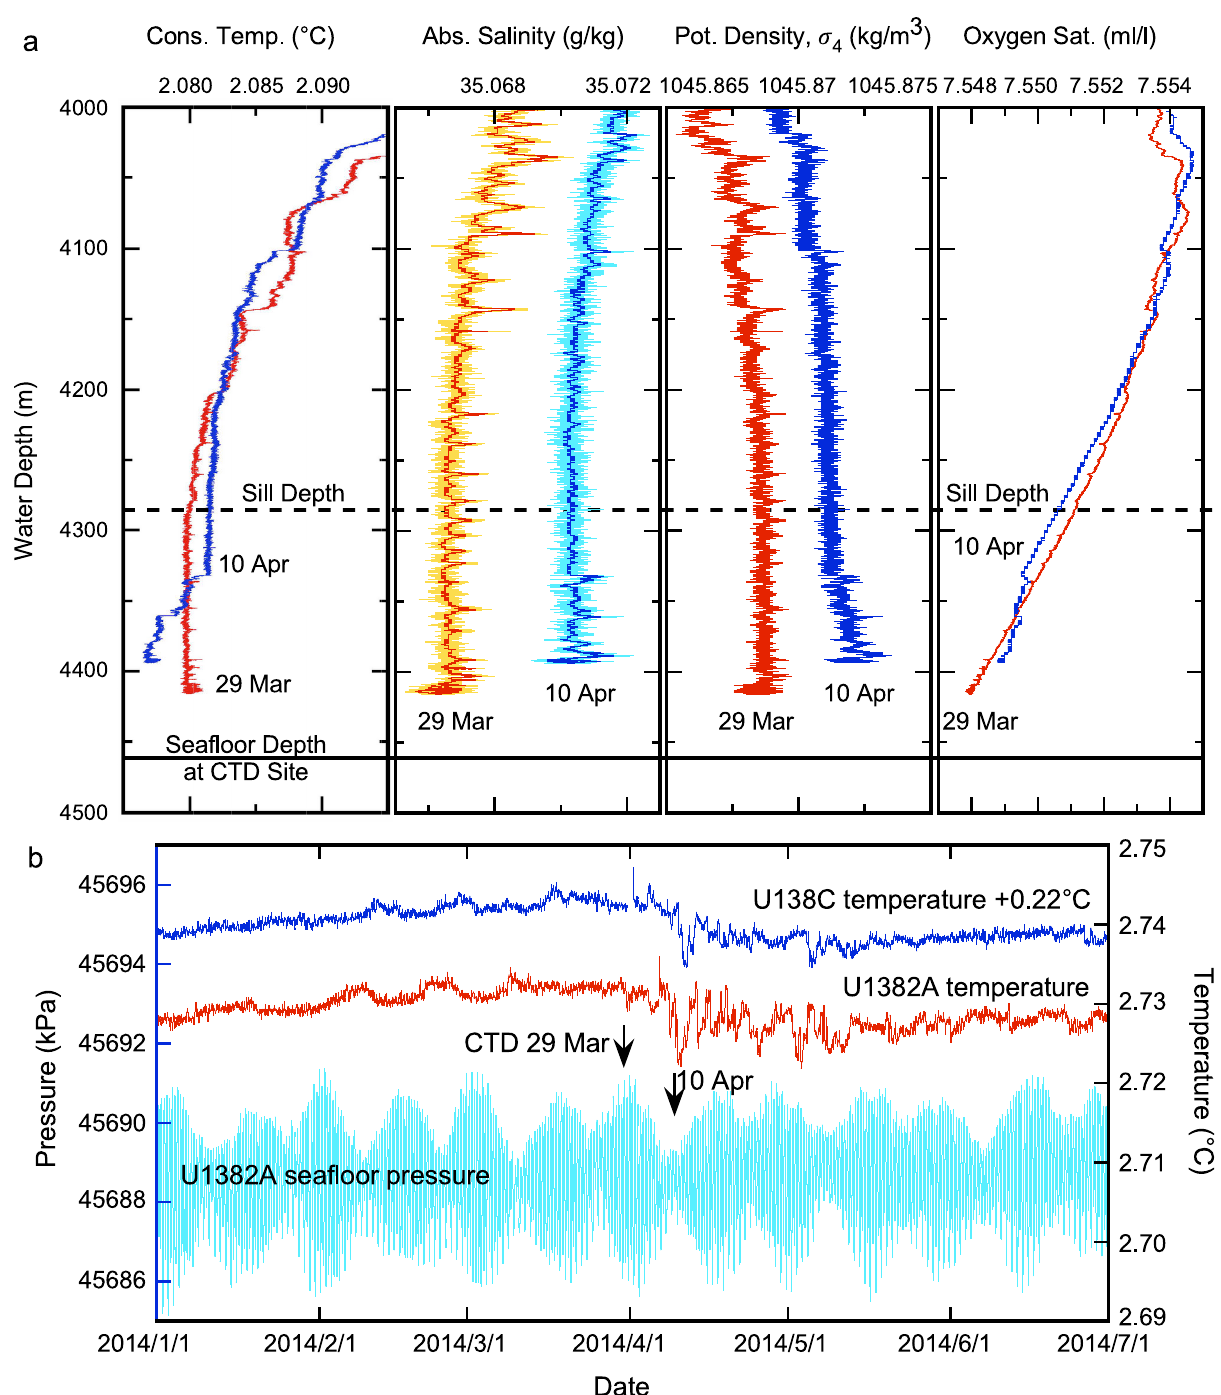
Fig. 3 CTD and sea fl oor pressure – temperature data spanning the small cooling event of April 2014. This event was clearly registered at both Holes U1382A and U1383C (Fig. 2). a Plots of Conservative Temperature, Absolute Salinity, neutral density, and oxygen saturation of bottom waters over North Pond for two CTD casts in 2014 that bracketed the cooling event. Properties from the 29 March CTD cast are shown in red, properties from the 14 April CTD cast in blue. The dark centers of the Absolute Salinity pro fi les show results of smoothing using a ∼ 0.5 m box fi lter. b Expanded record of sea fl oor pressures recorded at Hole U1382A (cyan) and bottom water in-situ temperatures recorded at Holes U1382A (red) and U1383C (blue) during the fi rst six months of 2014, illustrating the fortnightly ( ∼ biweekly) cycles in tidal amplitudes in North Pond and the times of the two 2014 CTD casts relative to these to interannual variability indicates that the fl ow dynamics in North Pond are linked to large-scale oceanic circulation processes.